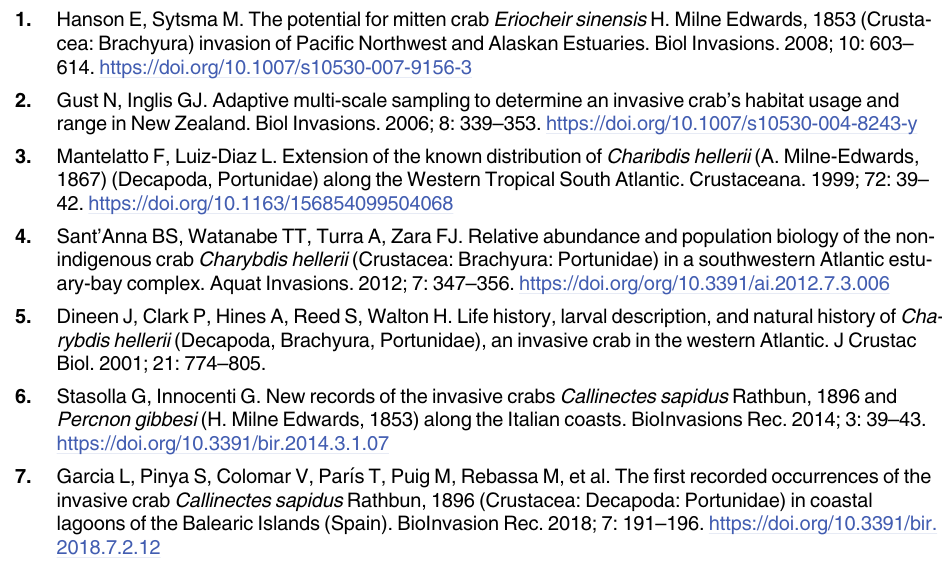
S4 Table. Embryonic development of Lysmata vittata (Stimpson, 1860). Volume and area of the egg, yolk area of the egg and percentage (%) of the area of the egg occupied of yolk per replicate in each period of the embryonic